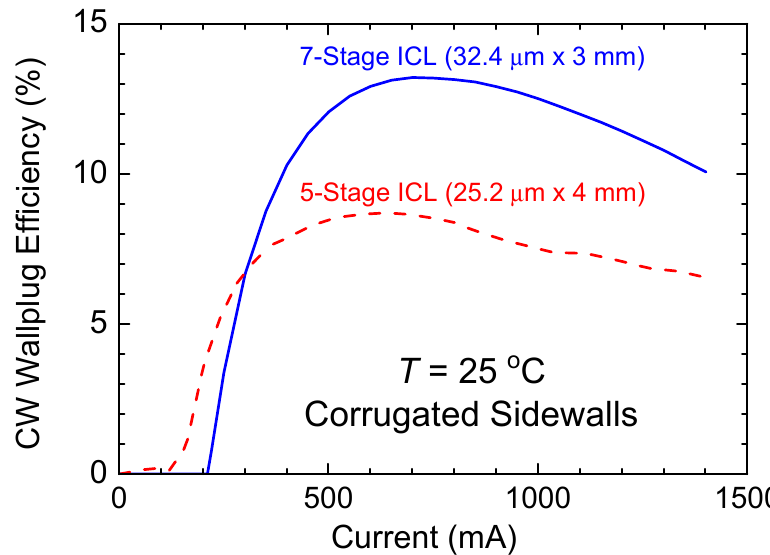
Figure 10. Wallplug efficiency at T = 25 °C as a function of the cw injection current for a 7-stage ICL narrow ridge with 32.4 μ m width and 3 mm length ICL (blue), along with the corresponding dependence for a 5-stage narrow ridge with corrugated sidewalls and roughly similar dimensions of 25.2 μ m × 4 mm (red). Both devices had corrugated sidewalls and were mounted epi-side-down with HR/AR facets [77].